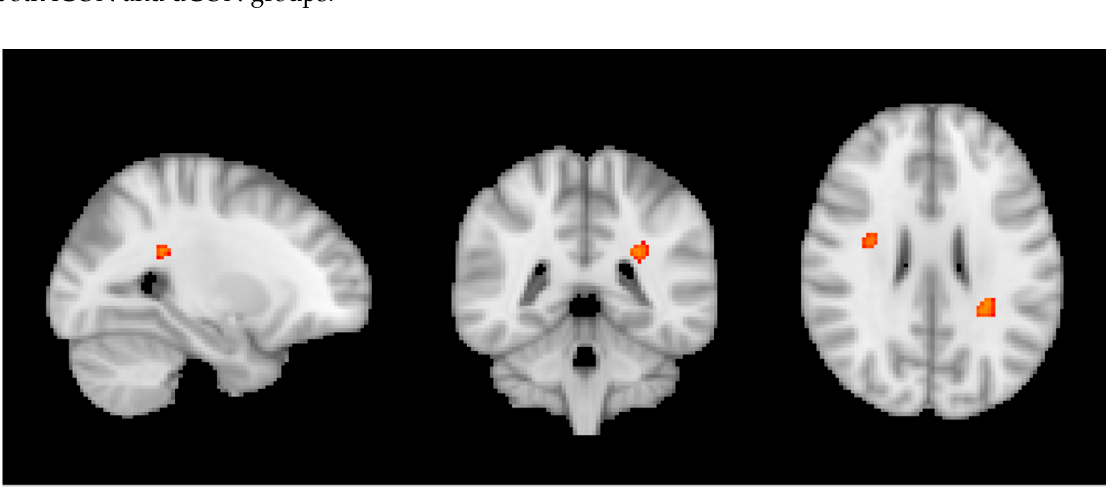
Figure 3. Negative correlation between caffeine and VBM for only sCON individuals. p < 0.05 TFCE corrected.